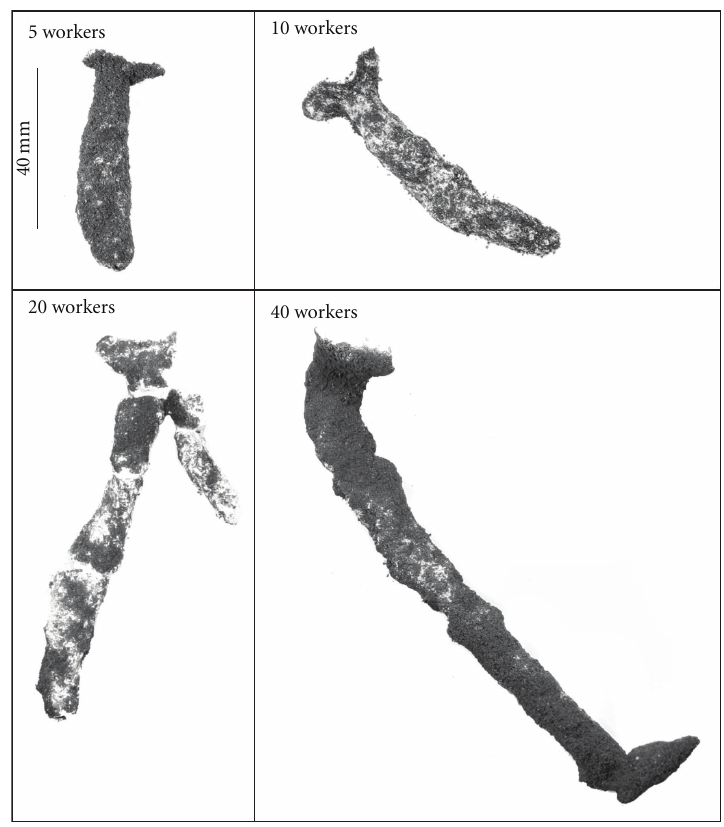
Figure 3: Structures produced by groups of Atta sexdens rubropilosa workers, in groups of 5, 10, 20, and 40, throughout 48